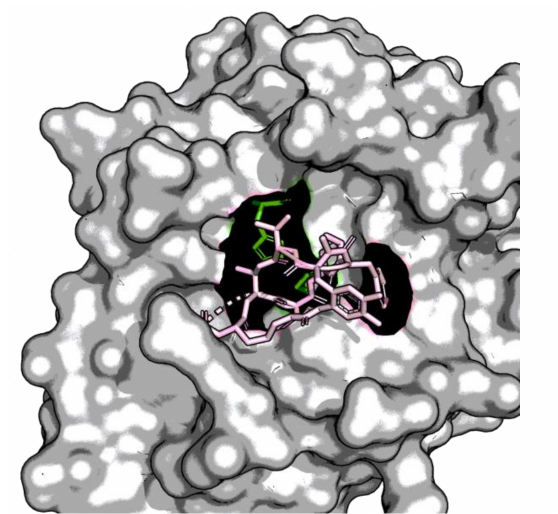
Figure 12. Crystal structure of porcine pancreatic elastase in complex with S (PDB code: 1QR3) [115]. The proximity of His-57 and Ser-195 residues (green) and the inhibitor molecule (pink) is